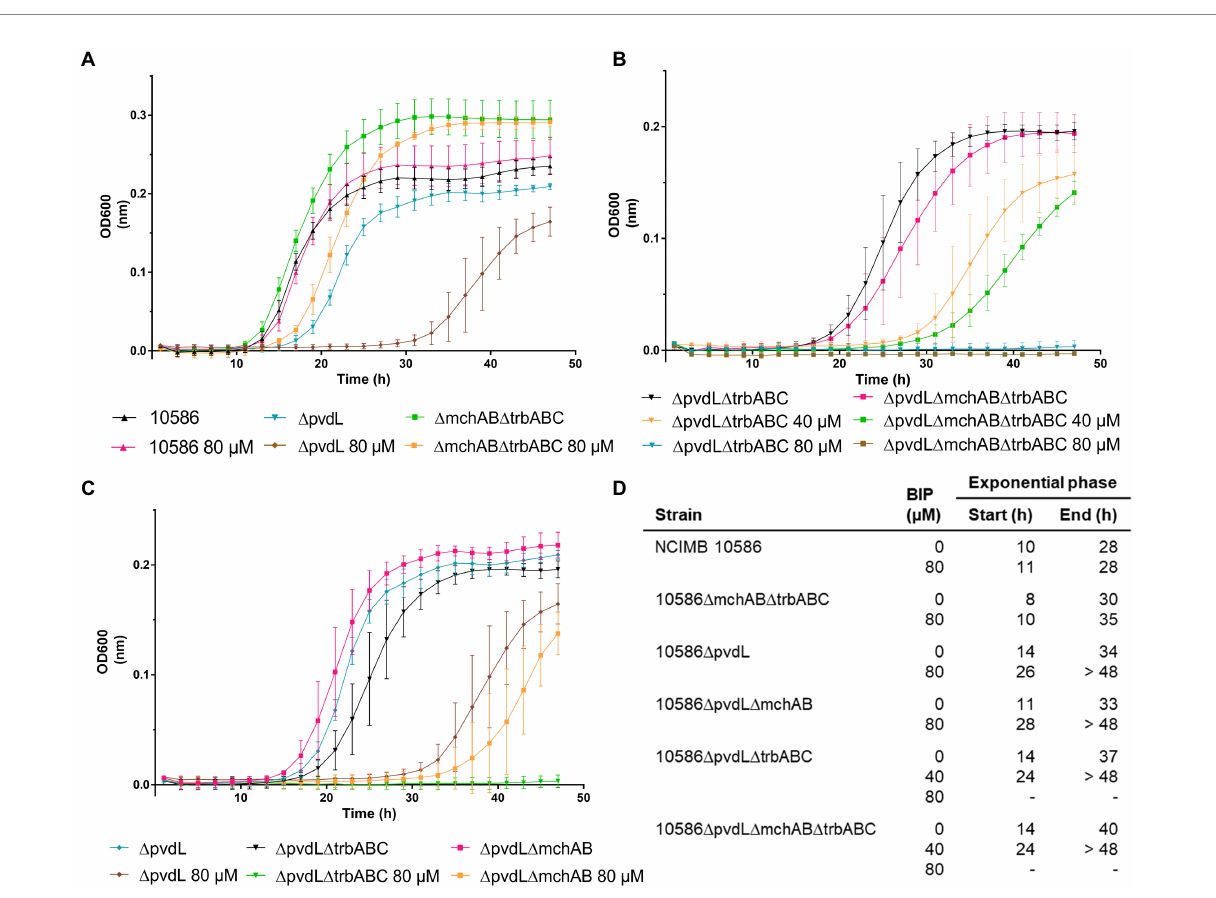
FIGURE 6 Characterization of the importance of pyoverdine, mupirochelin and triabactin for the growth of the bacterial strain in iron-stress conditions. (A) Effect of pyoverdine production on the strain fitness. The 2,2 ′ -bipyridine concentration does not affect the wild type growth curve. 10586 ∆ mchAB ∆ trbABC mutant which only produces the siderophore pyoverdine is tolerant to the highest 2,2 ′ -bipyridine concentration added, with only a small delay compared to its growth in CAA medium. Surprisingly, the exponential phase of this mutant last longer compared to the wild type, leading to a higher final cell concentration in the culture even under iron limitation. Absence of pyoverdine production has a great impact on 10586 ∆ pvdL growth and reduces its tolerance to 2,2 ′ -bipyridine without erasing it. (B) Effect of mupirochelin on the strain fitness. Mupirochelin production by 10586 ∆ pvdL ∆ trbABC is not sufficient to improve the strain growth compared to the siderophore-negative mutant 10586 ∆ pvdL ∆ mchAB ∆ trbABC. Both mutants are unable to grow in 80 μ M 2,2 ′ -bipyridine. (C) Effect of triabactin on the strain fitness. Triabactin production alone is responsible for the growth up to 80 μ M 2,2 ′ -bipyridine. (D) Summary of the growth curves obtained for the strains tested. Exponential phase start and end times were determined graphically. Addition of 80 μ M 2,2 ′ -bipyridine (BIP) inhibits 10586 ∆ pvdL ∆ trbABC and 10586 ∆ pvdL ∆ mchAB ∆ trbABC